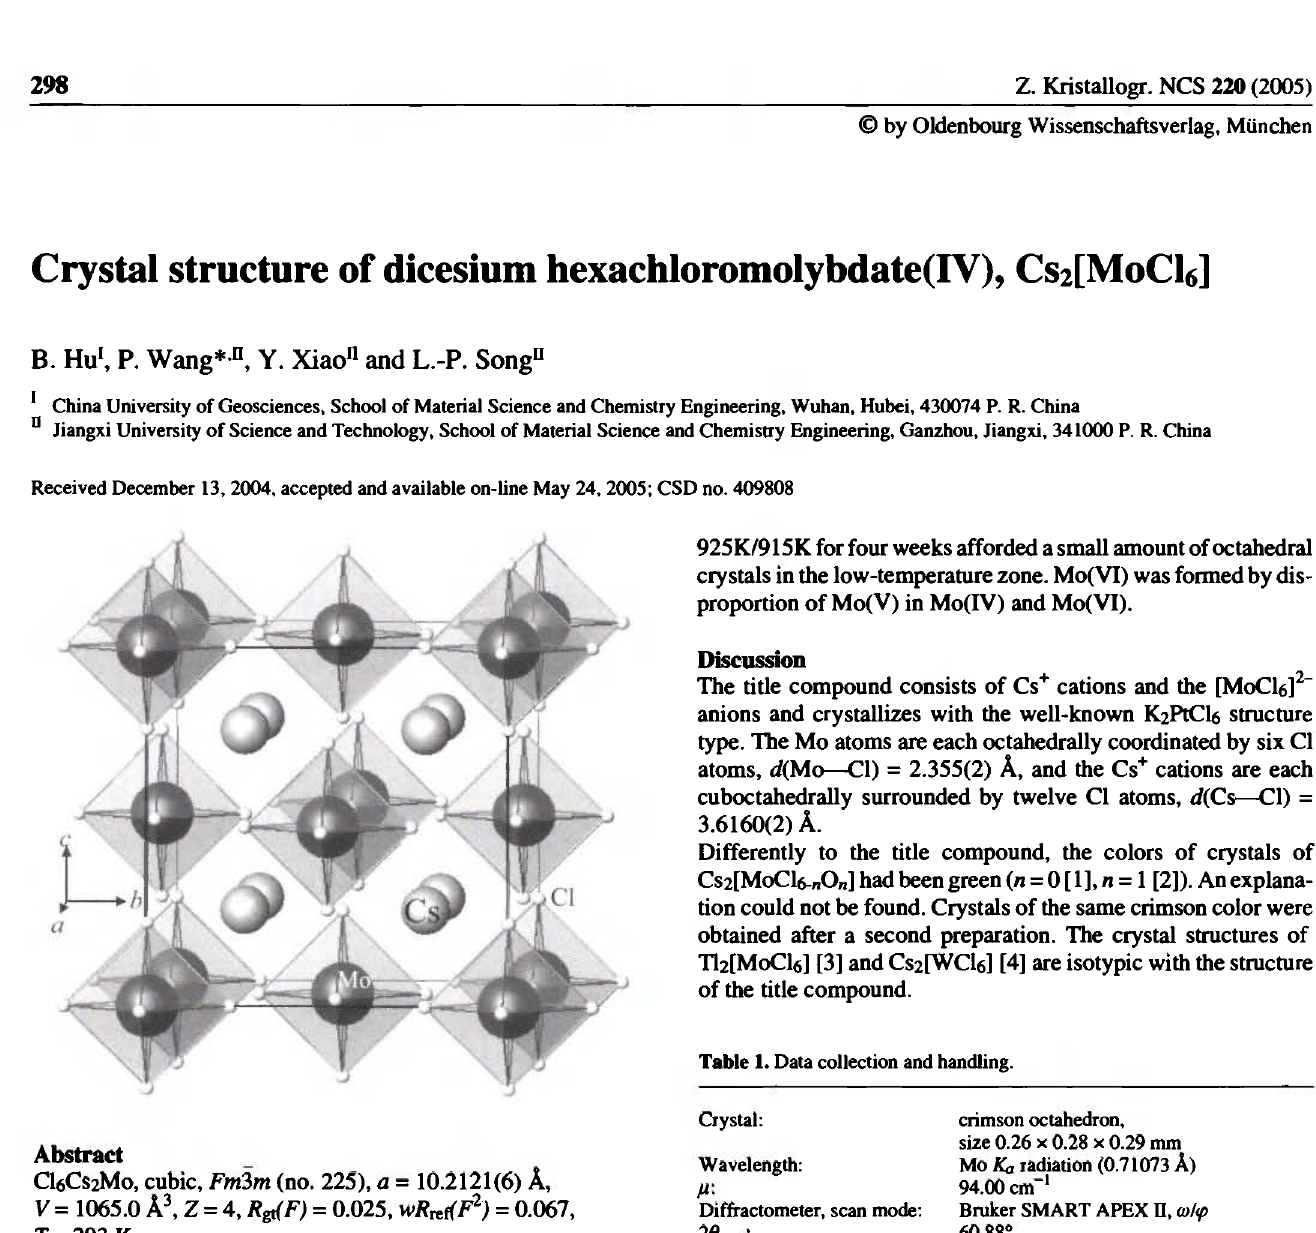
Table 2. Atomic coordinates and displacement parameters (in A 2